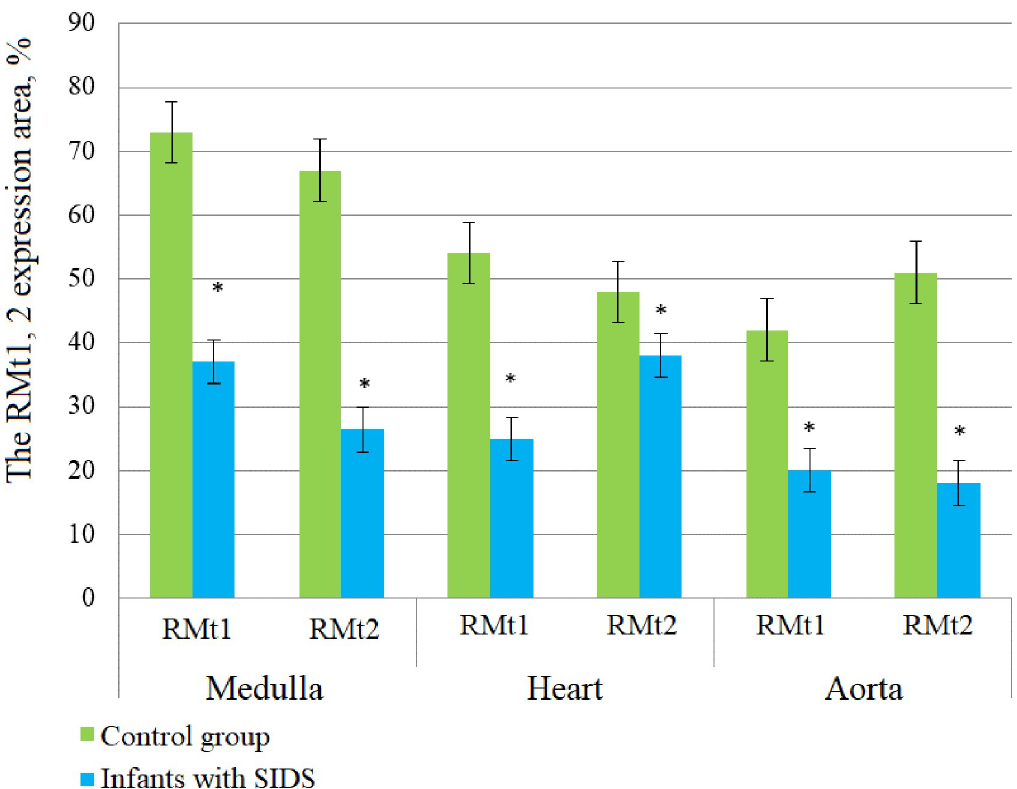
Fig 8. The expression area of receptors for melatonin 1 (RMt1) and 2 (RMt2) (mean ± SD) in medulla, heart, and aorta tissues in the control group and in infants with SIDS. � p < 0.05 –as compared with the respective index in the control group.